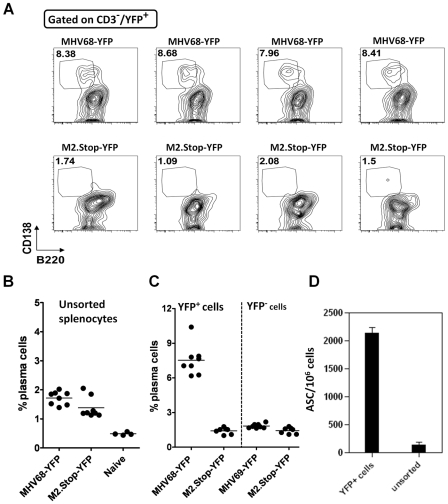
Access of MHV68 to the plasma cell reservoir during MHV68 chronic infection requires a functional M2 gene.Mice were infected with a 100 pfu of either MHV68-YFP or M2.Stop-YFP viruses via intranasal inoculation. (A) The absence of MHV68 infected plasma cells in mice infected with the M2.Stop-YFP virus. Flow cytometry analyses, gated on YFP+ cells, to determine the presence of virus infected plasma cells (CD138+/B220−) in the spleen at day 16 post-infection. Data shown were compiled from representative wild type (MHV68-YFP) and M2 null virus (M2.Stop-YFP) infected mice (4 mice per virus). (B) Similar levels of total plasma cells in mice infected with wild type vs. the M2 null MHV68. Compiled data showing the percentage of plasma cells present in wt MHV68 (MHV68-YFP) infected or M2 null virus (M2.stop-YFP) infected spleen cells at day 16 post-infection. (C) Percentage of plasma cells in virus infected (YFP+) and uninfected (YFP-) splenocytes harvested at day 16 post-infection. (D) ELISPOT analyses of antibody secreting cells (ASC) present in wt MHV68 (MHV68-YFP) infected splenocytes (YFP+ cells) or bulk splenocytes harvested at day 16 post-infection.